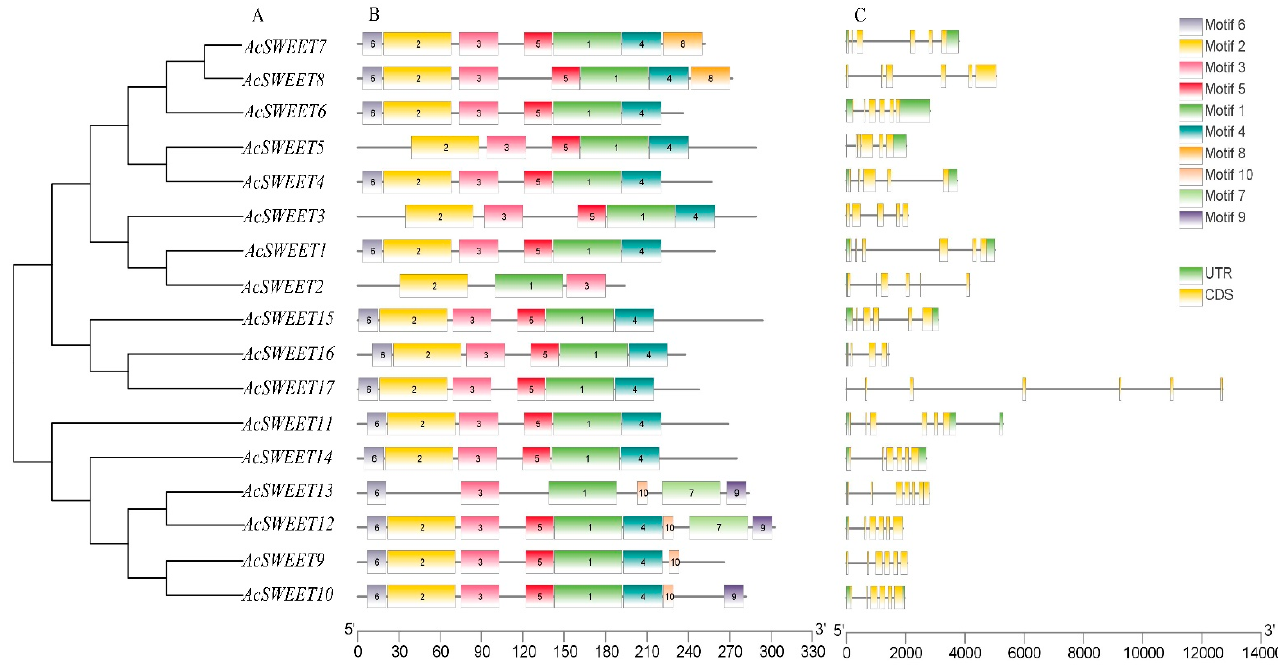
Figure 3. Evolutionary, gene structural and motif analyses of AcSWEETs in pineapple. ( A ) phyloge- netic tree of candidate amino acid sequences was constructed using the neighbor-joining method with 1,000 bootstraps in MEGA 6.0. ( B ) The conserved motifs of AcSWEETs proteins were analyzed using the MEME tool. ( C ) The gene structure of AcSWEETs was identified by TBtools.